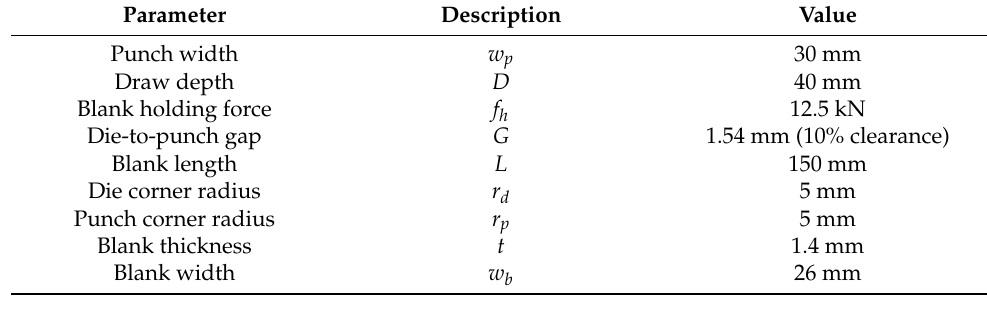
Table 6. Geometric and process variables for the drawing wear test [36].